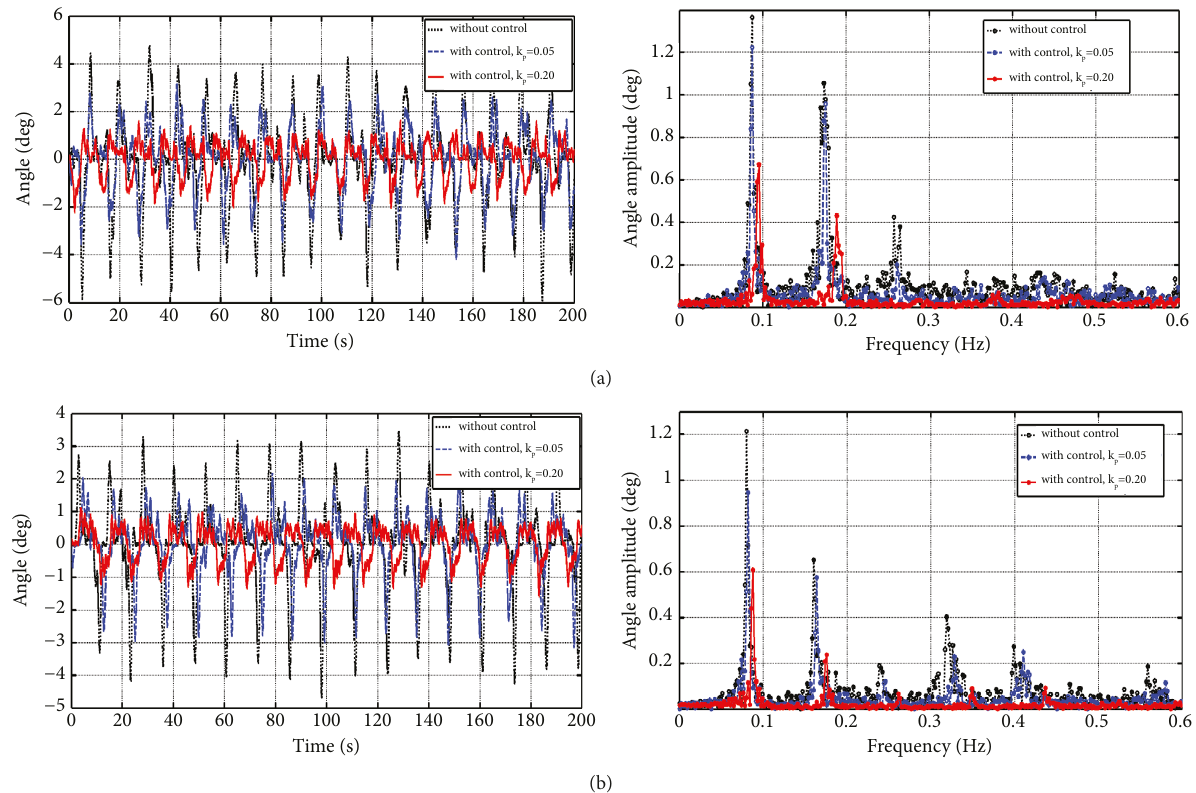
Figure 14: Vibration control experiments with passive damping: (a) Experiment III ; (b) Experiment